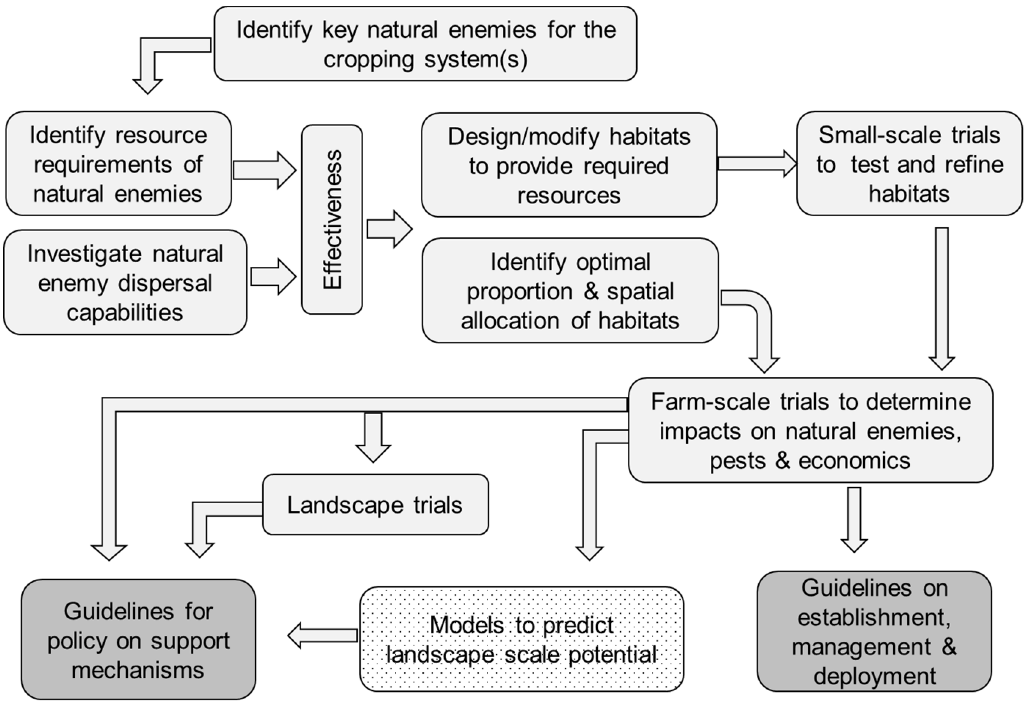
Figure 2. Process to exploit biocontrol potential of seminatural habitats.